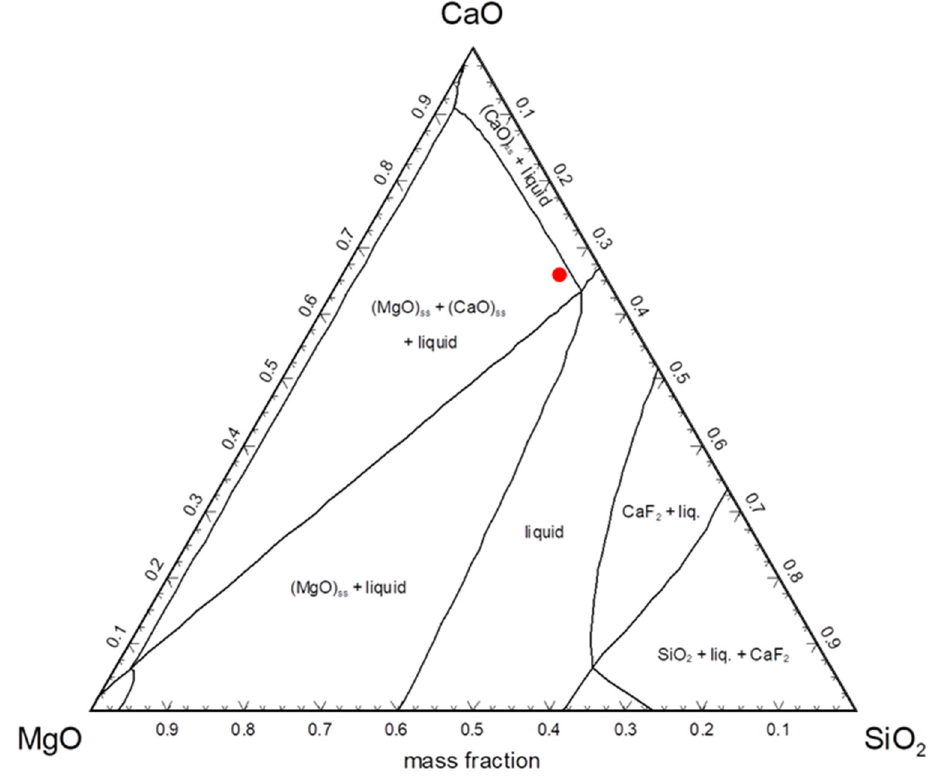
Figure 1. Pseudo-ternary CaO-SiO 2 -MgO-15%CaF 2 phase diagram (isothermal section at 1600 °C) as plotted with FactSage 8.1 using the FToxid database (SLAGH liquid slag model). The red dot is the aimed composition to ensure double saturation with both (MgO) ss (periclase) and (CaO) ss (lime).